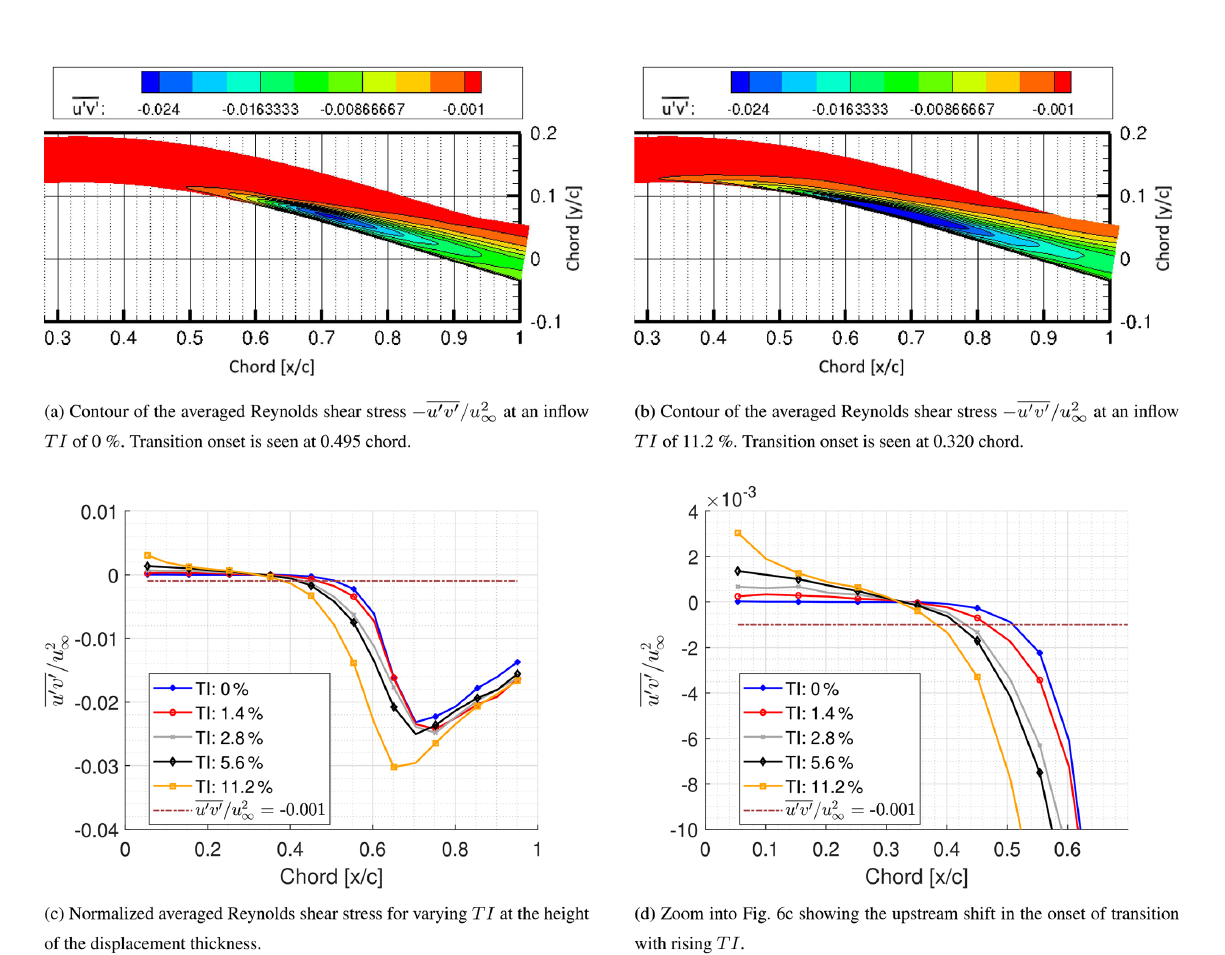
Figure 6. Contours and profiles of the averaged Reynolds shear stress showing the upstream shift in the onset of transition according to the transition criterion based on the threshold of Reynolds shear stress ( − u (cid:48) v (cid:48) /u 2 ∞ = 0 . 001) (Yuan et al.,